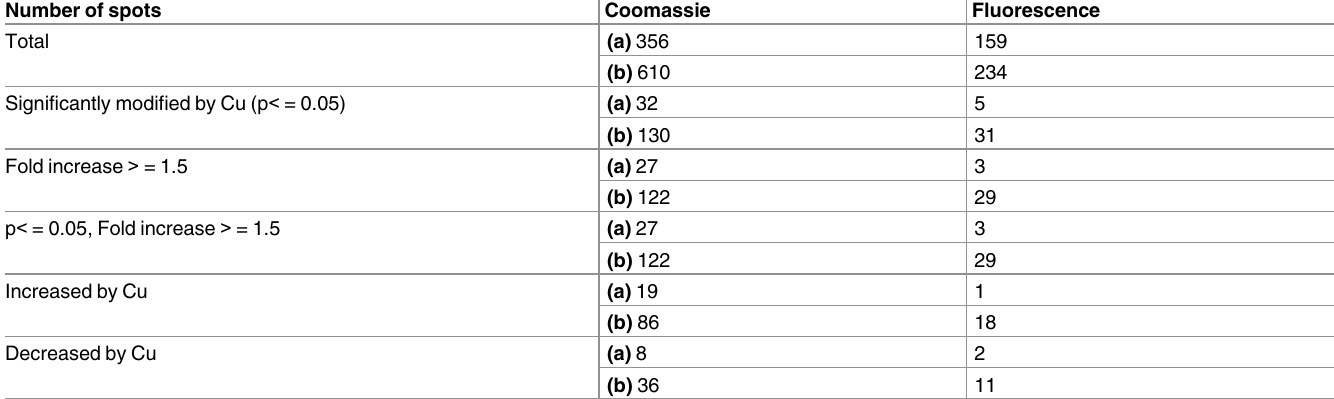
Table 6. Proteins containing carbonyl groups (FTSC labeling) in the seedlings (3 days-old) (a) and the cotyledons (9 days-old) (b) of germinated bean seeds in the presence of H 2 O (CTR) or 200 μ M